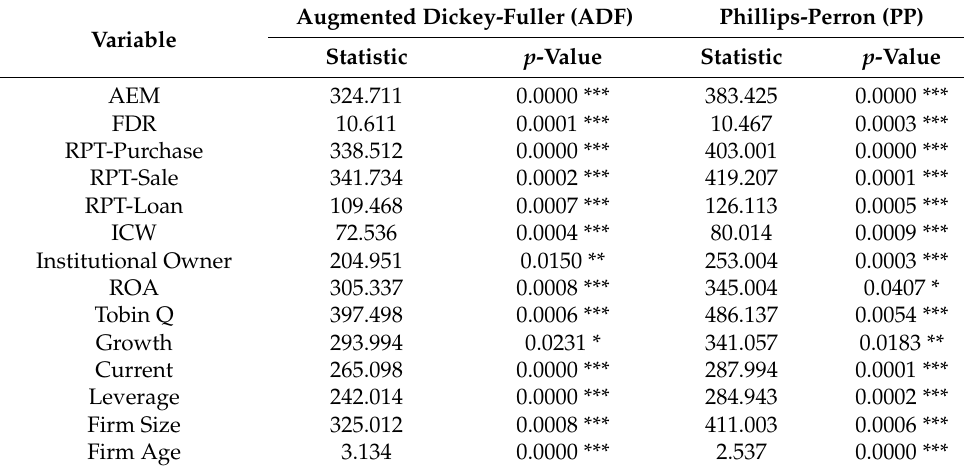
Table 5. The results of the Unit Root Test.